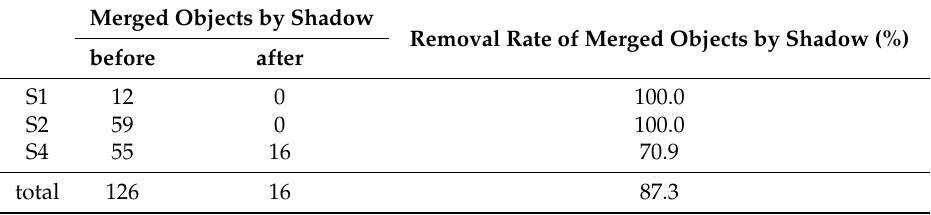
Table 3. Removal rate of merged objects by